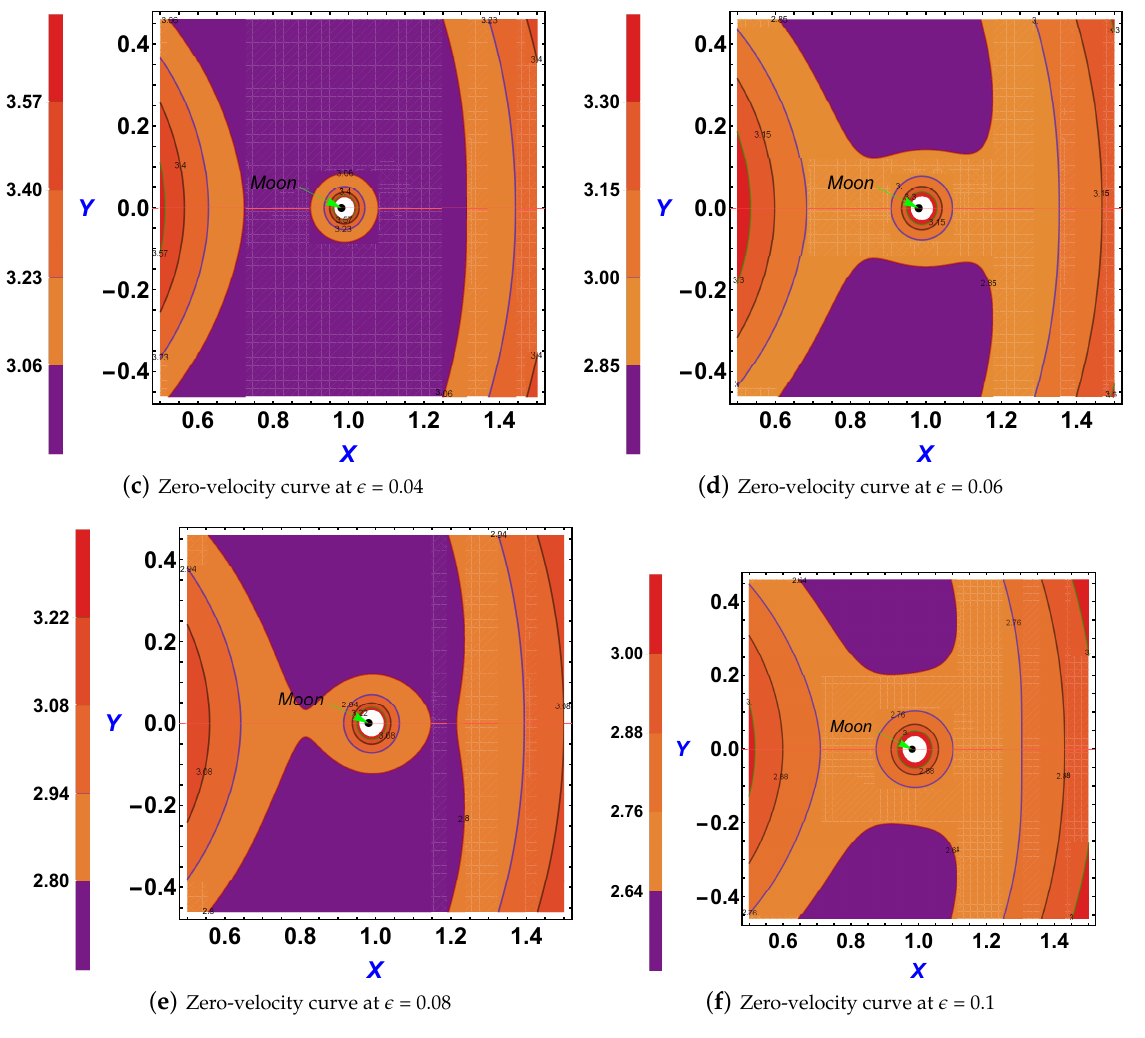
Figure 2. Variation in zero-velocity curve near the Moon due to the effect of the continuation fractional potential parameter (cid:101) .